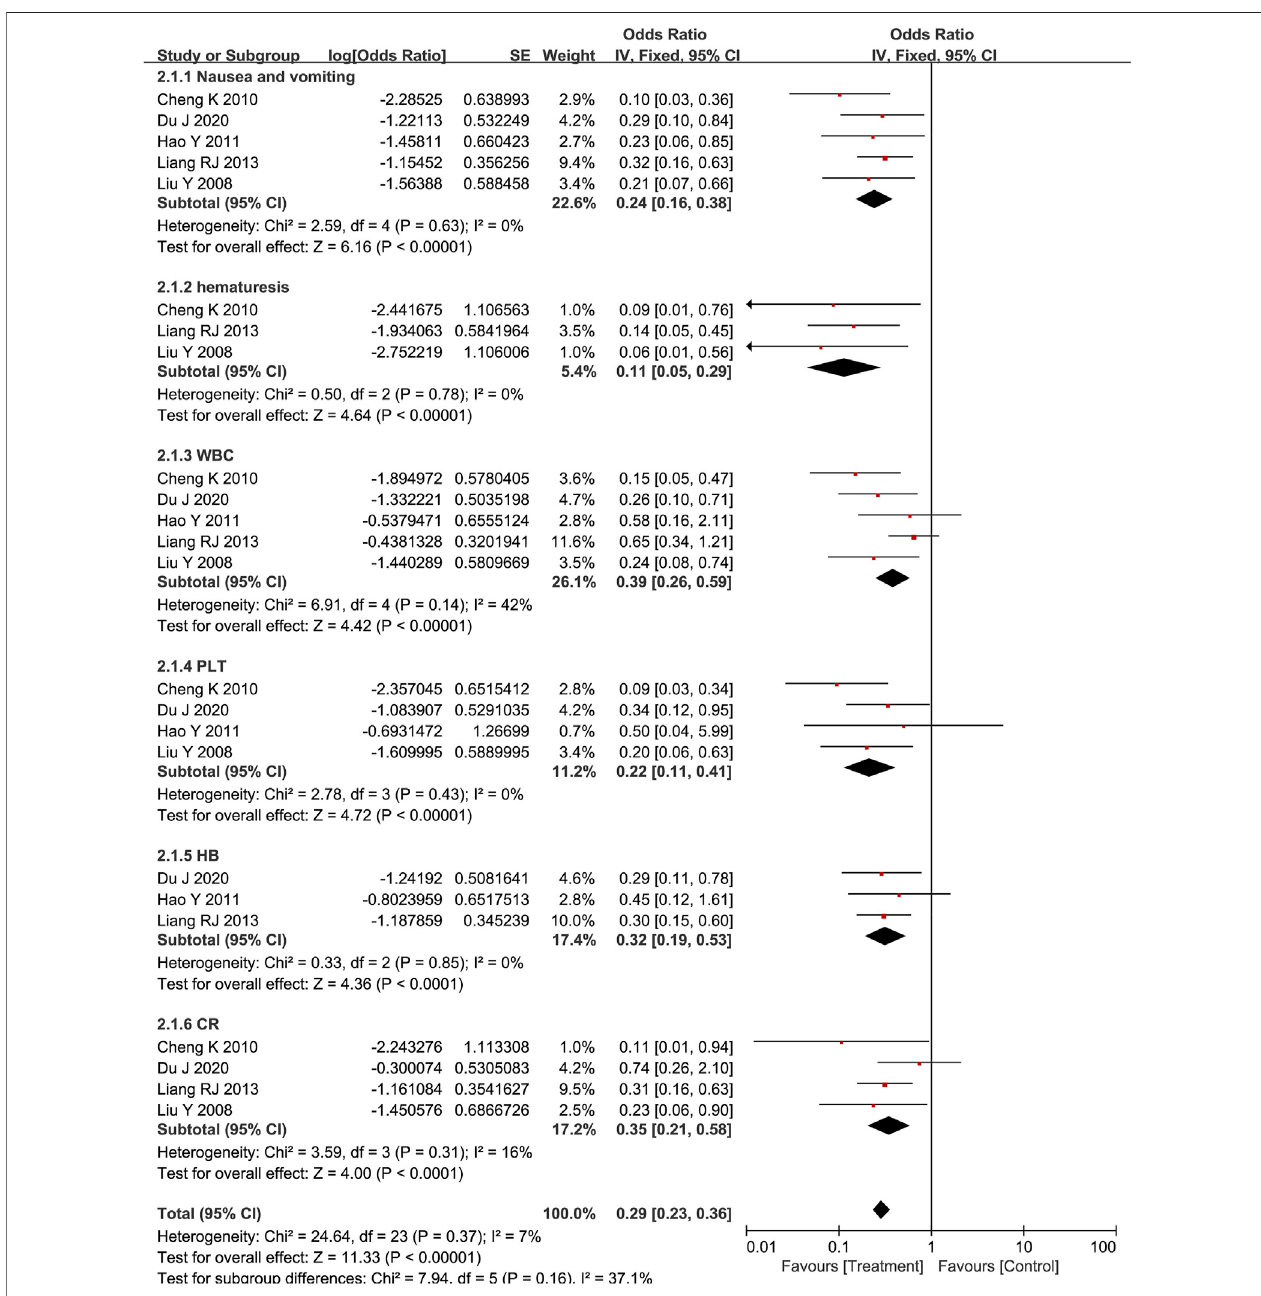
FIGURE 4 | Graded outcome data of side